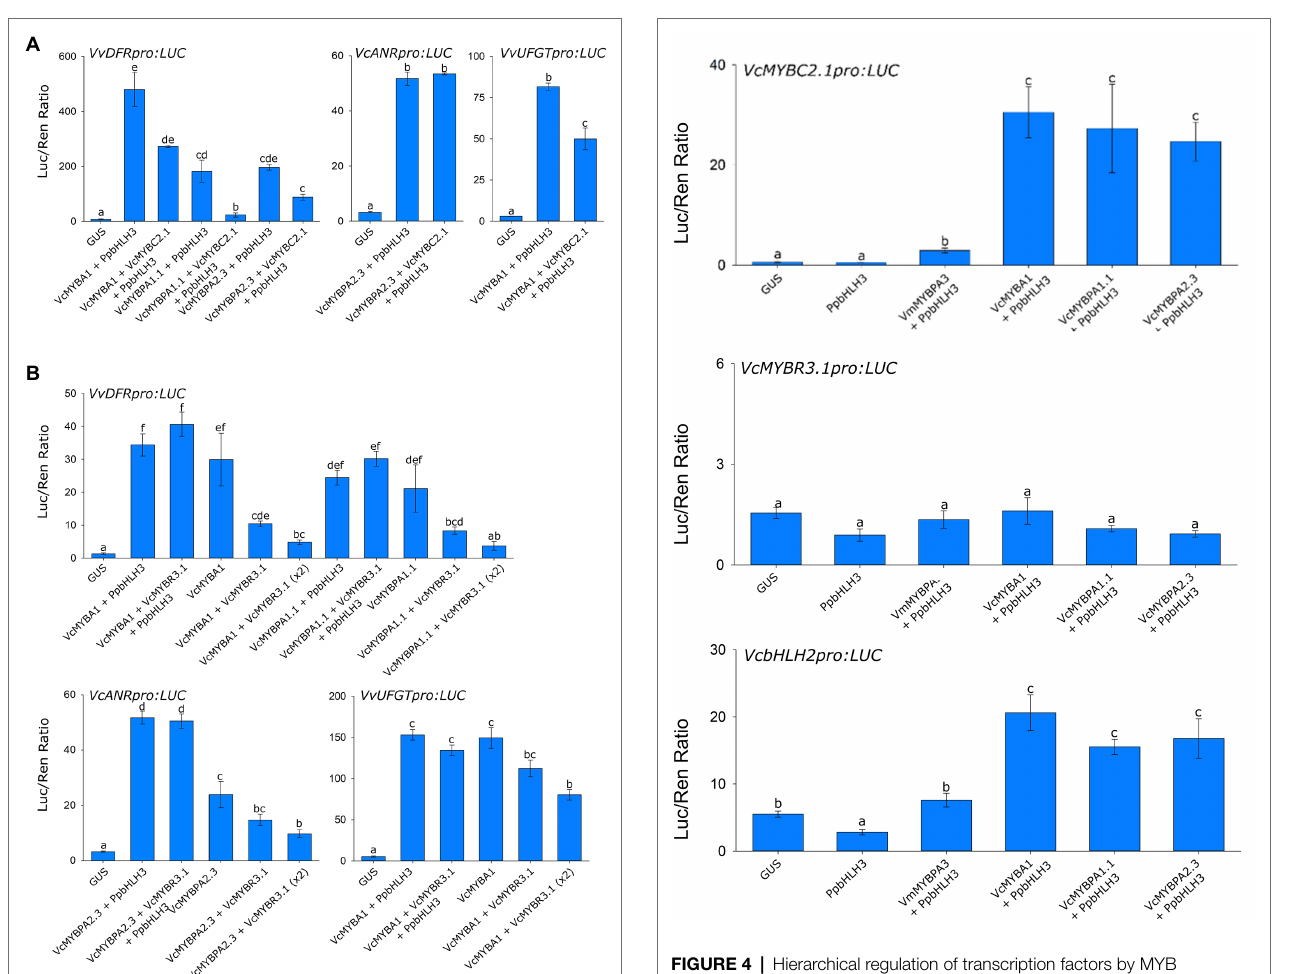
FIGURE 4 | Hierarchical regulation of transcription factors by MYB activators. Promoter activation assays were performed in the leaves of N. benthamiana via Agrobacterium- mediated co-infiltration of SG5, SG6 and MYBPA1-type MYB activators, with PpbHLH3 , against the VcMYBC2.1, VcMYBR3.1, VcMYBPA1.1 and VcbHLH2 promoter:Luciferase constructs. Values represent the mean of three biological replicates. Error bars are ± SEM. Letters indicate significant differences between treatments, assessed by one- way ANOVA and post hoc Tukey’s test ( P < 0.05) on log-transformed